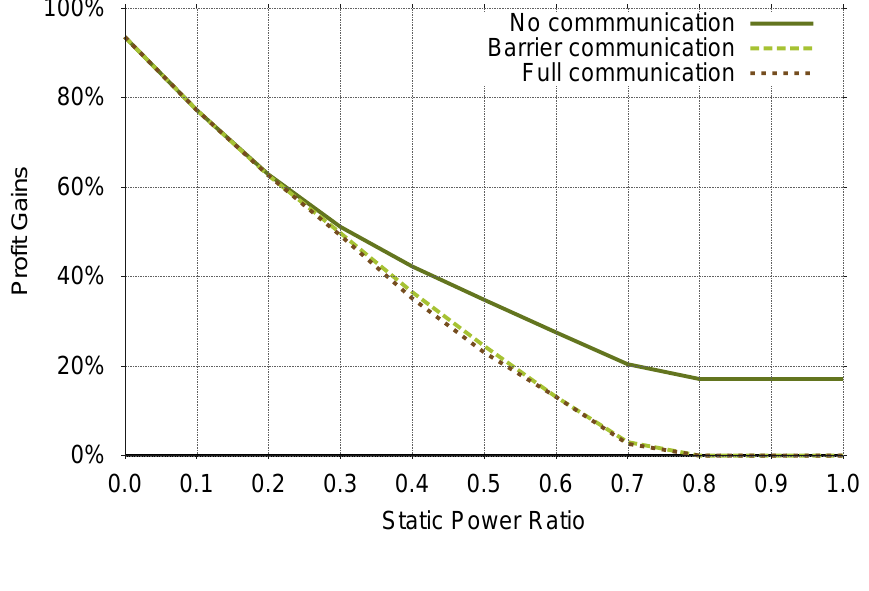
= 1.3 h, t = 2.6 R 1 R 2